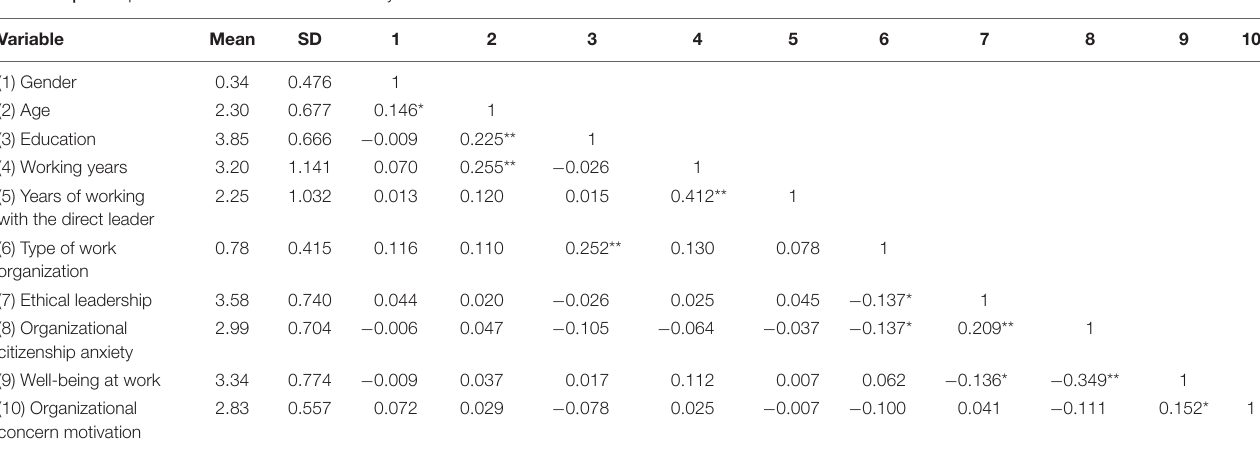
TABLE 3 | Descriptive statistics and correlation analysis.